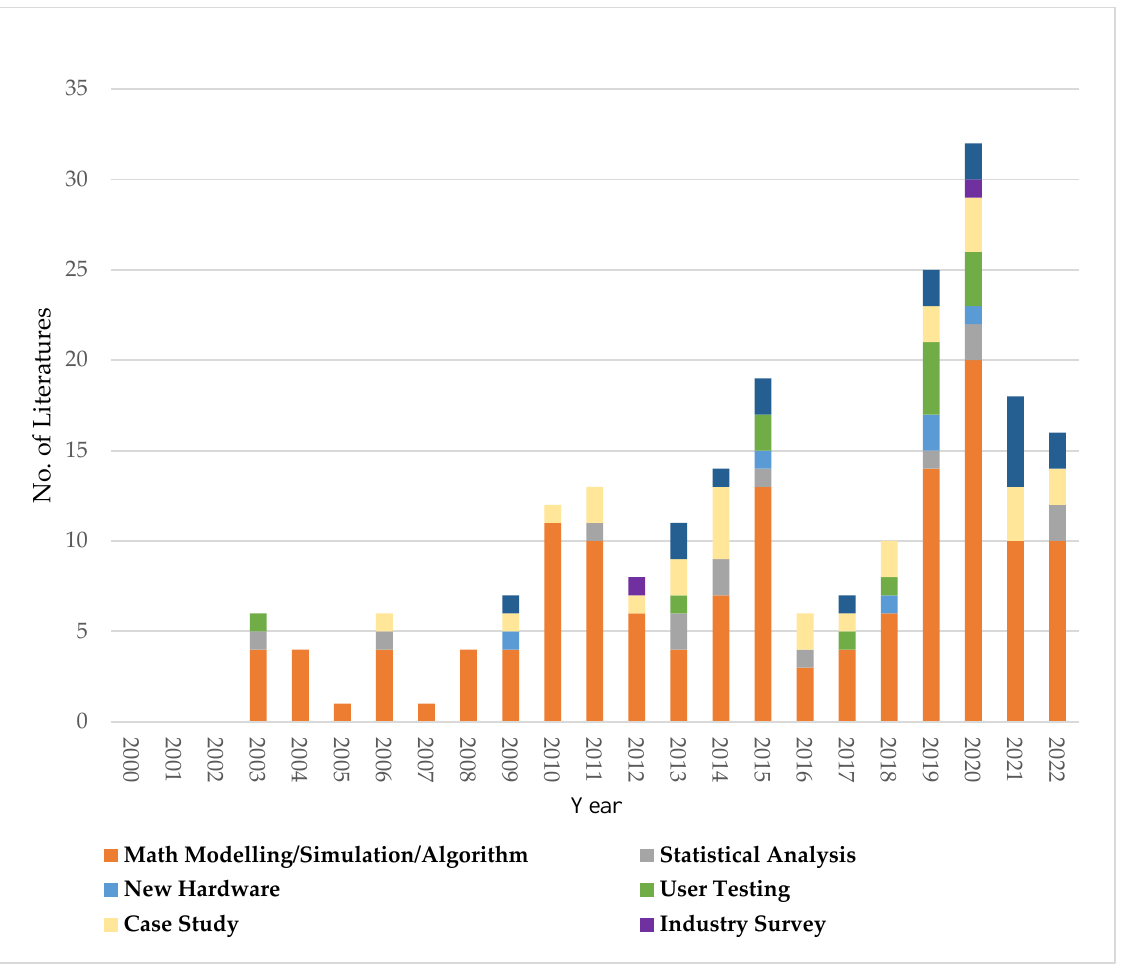
Figure 10. The trend of the most common methodologies .